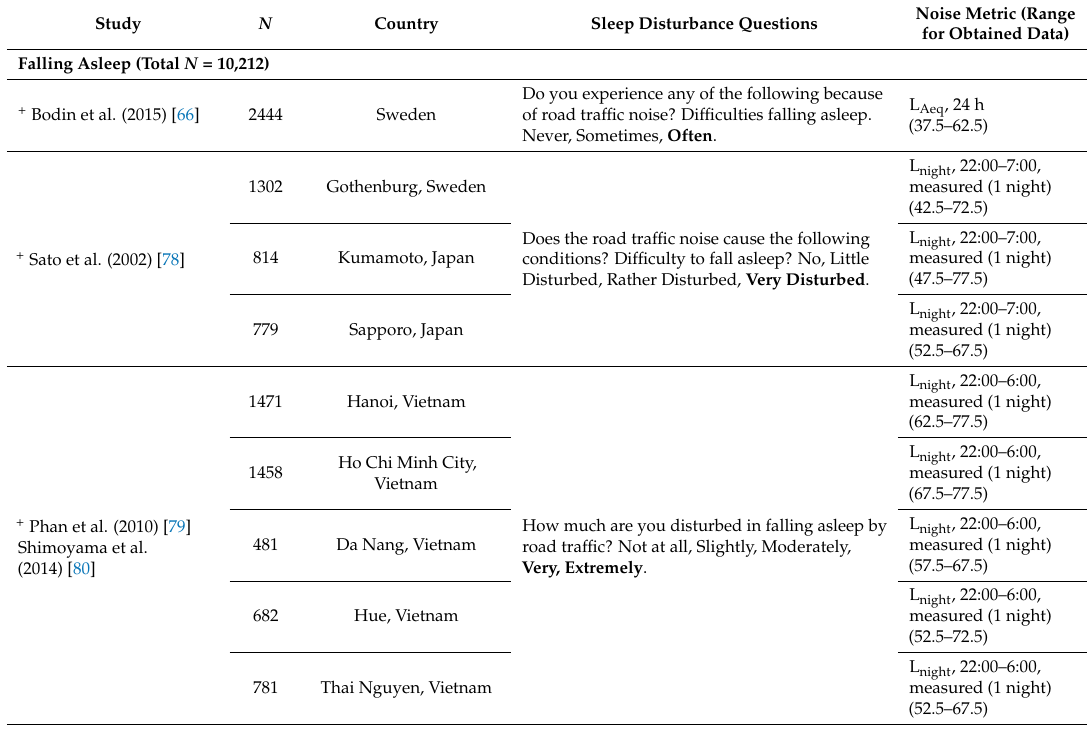
Noise Metric (Range Sleep Disturbance Questions for Obtained